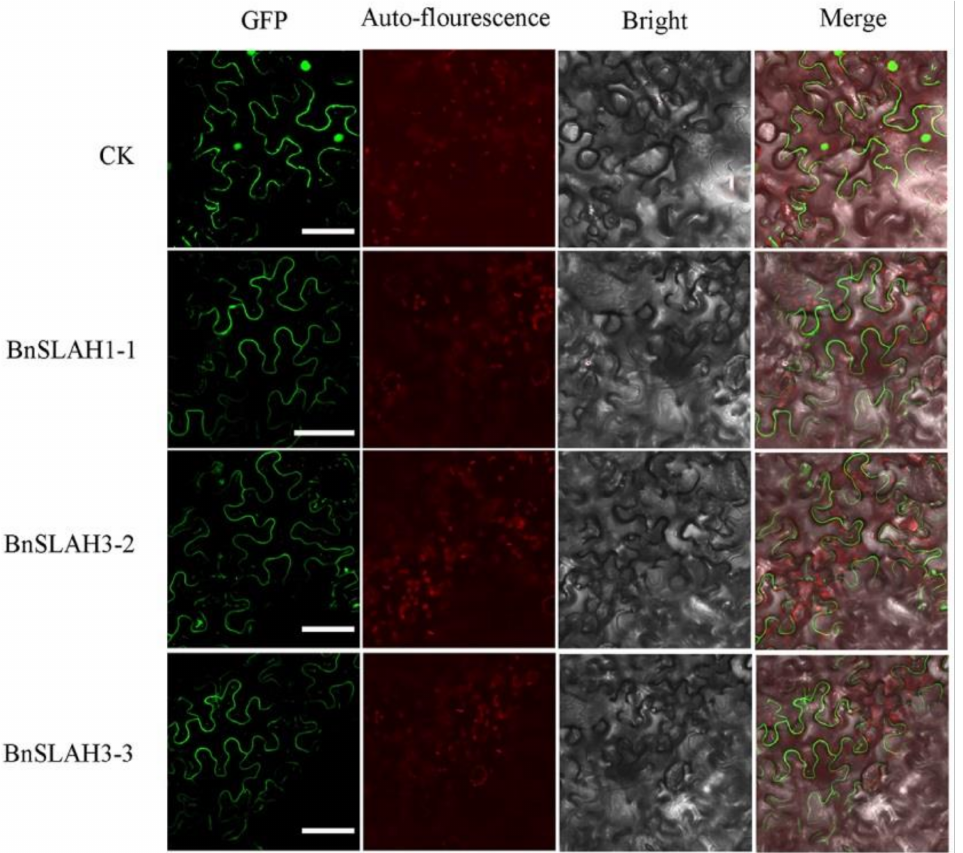
Figure 6. Subcellular localization of BnSLAC/SLAHs in B. napus . The selected BnSLAC/SLAH-GFP fusion proteins (BnSLAH1-1-GFP, BnSLAH3-2-GFP and PbrSLAH3-3-GFP) as well as 35S-GFP as the control were independently transiently expressed in tobacco leaves and imaged under a confocal microscope. Bars = 50 µ